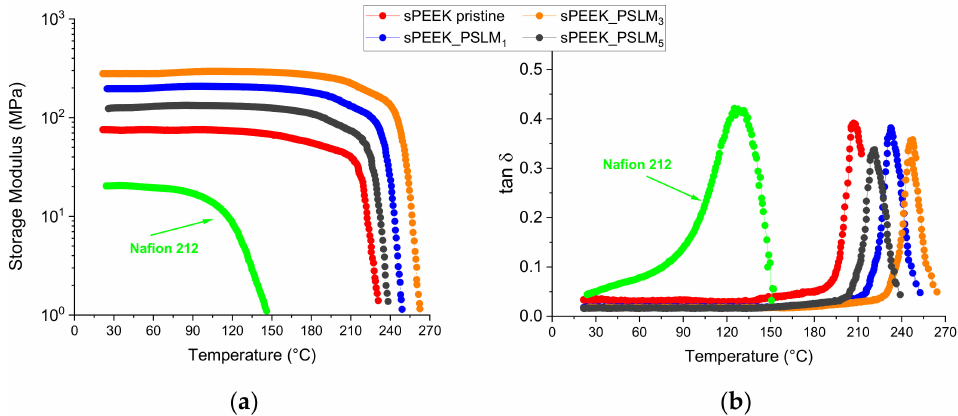
Figure 2. ( a ) Storage modulus (E’) and ( b ) tan δ of the sPEEK-based membranes as a function of